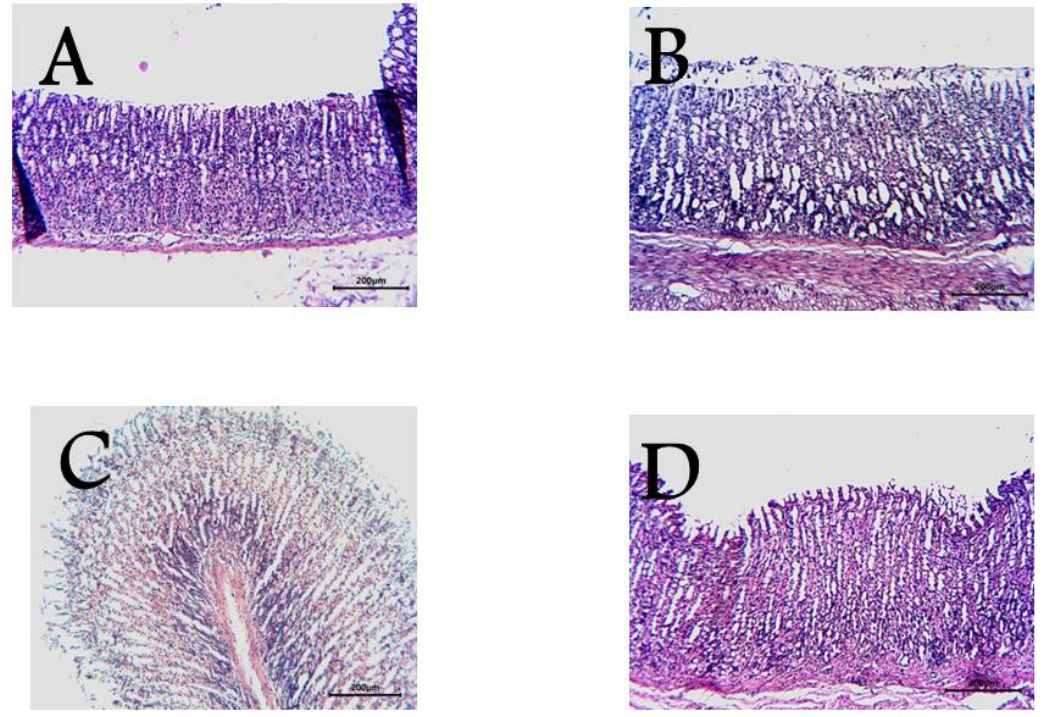
Figure 3. Light micrographs showing the effect of guava seed extract on Indomethacin-induced gastric ulcers of rats. ( A ) Group A (normal mucosa), ( B ): Group B (Indomethacin-induced gastric mucosal lesions), ( C ): Group C (cimetidine treated group show low mucosal lesions), ( D ): Group D (pretreatment of rats with guava seed extract) show no mucosal alterations.